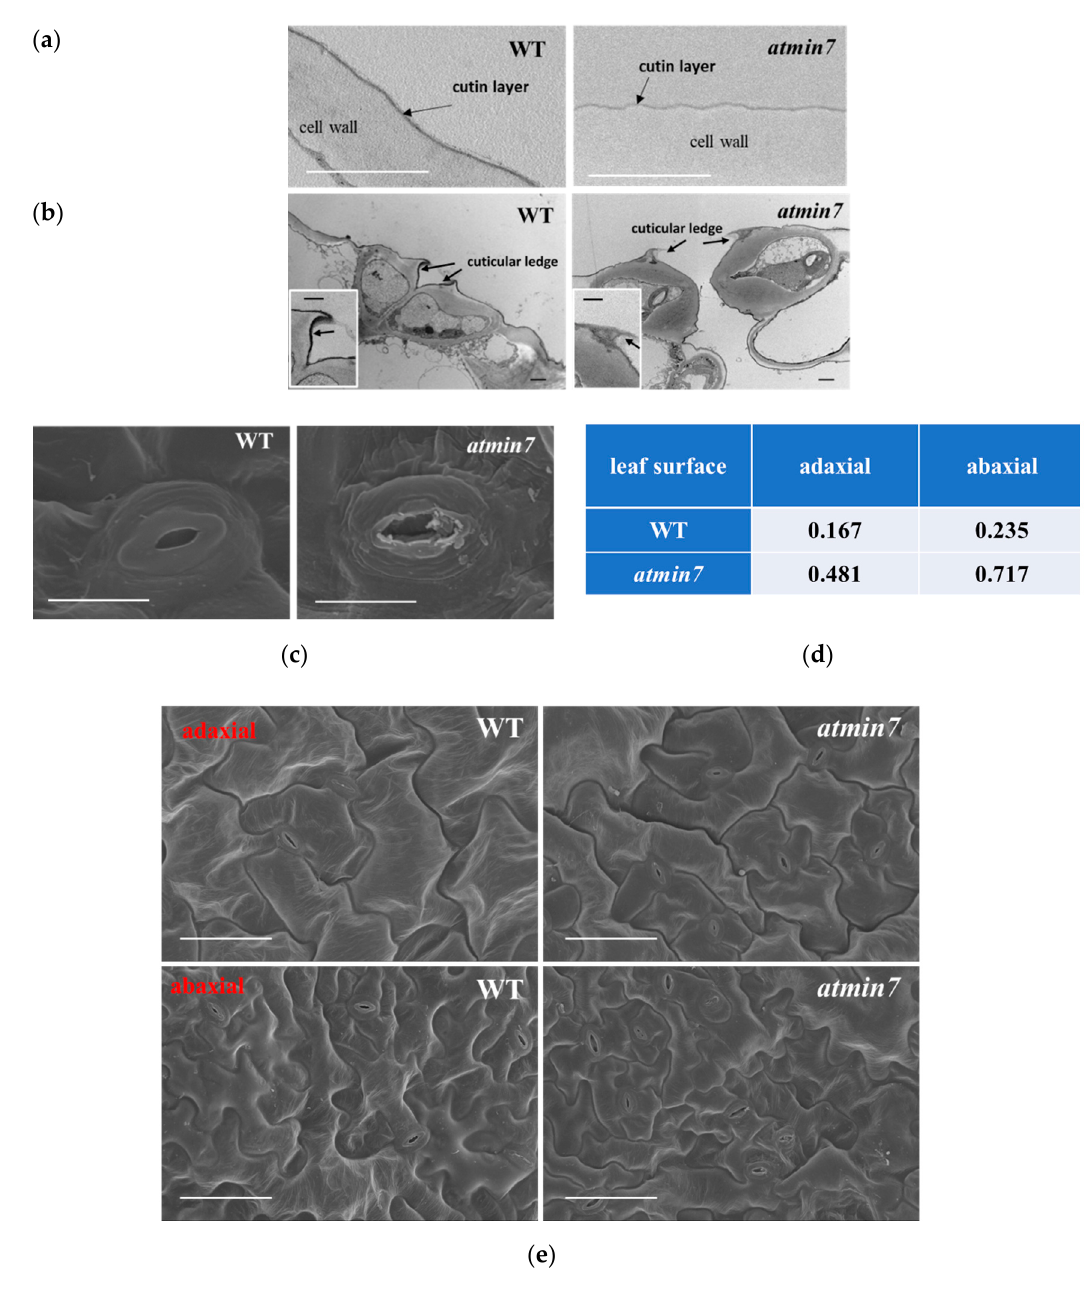
Figure 3. TEM and SEM reveal the defective cuticle and stomatal structure in the leaves of atmin7 plants. ( a ). TEM images of the cutin layer (indicated by black arrows) on adaxial surfaces of WT and atmin7 leaves (scale bars = 1 µm). ( b ). TEM images of the transdermal sections of leaf guard cells. Black arrows indicate the cuticular ledges (scale bars = 1 µm). Insets are magnified images of the cuticular ledges (scale bars = 1 µm). ( c ). SEM images of stomata from abaxial surface of leaves from WT and atmin7 mutant plants (scale bars = 10 µm). ( d ). Frequency of defective stomata on WT and atmin7 leaf surface (adaxial and abaxial) detected by SEM (randomly selected 60 stomata for each group). ( e ). SEM images of adaxial and abaxial leaf surface of WT and atmin7 leaves (scale bars = 50 µm).